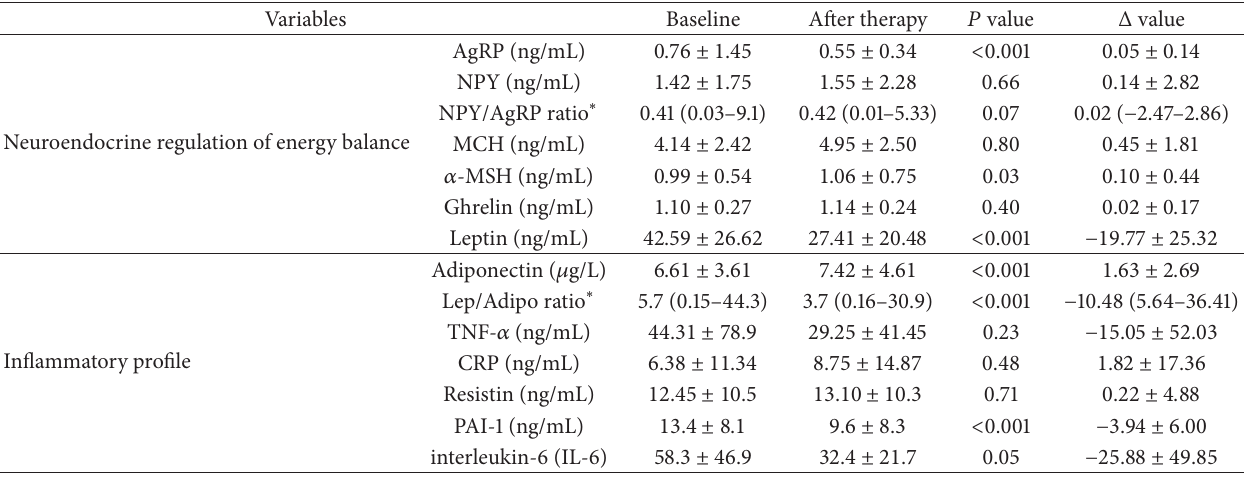
Table 4: Effects of interdisciplinary therapy in neuroendocrine regulation of energy balance and inflammatory profile.